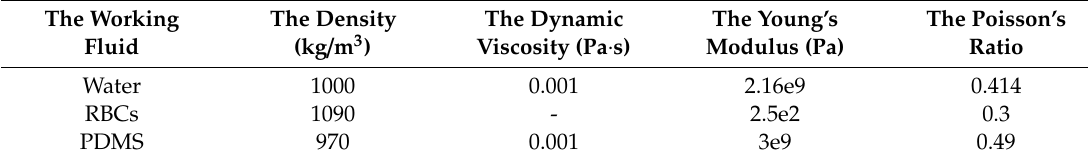
Table 2. The physical properties of the RBCs and working